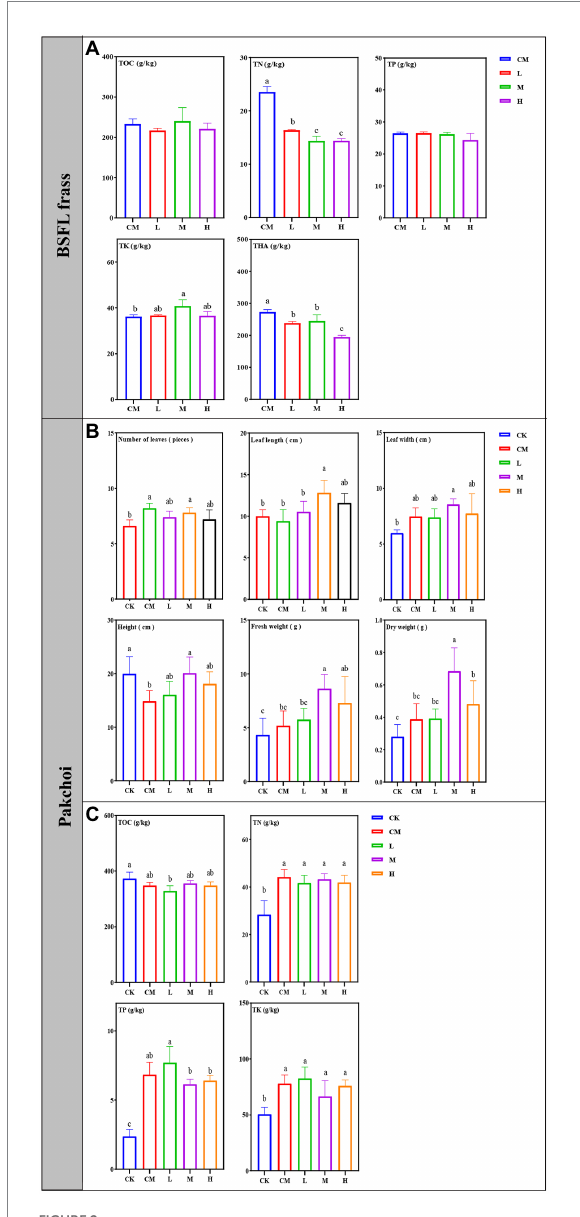
FIGURE 2 Physicochemical parameters of BSFL frass and pakchoi samples. (A) The contents of TOC, TN, TP, TK, and THA in BSFL frass among different treatments; (B) the leaf number, leaf length and width, height, fresh weight and dry weight of pakchoi among different treatments; (C) the contents of TOC, TN, TP, and TK in pakchoi among different treatments. Significant differences between the means were determined by Tukey’s test. Differences were considered significant when p < 0.05, and different lowercase letters indicate significant differences. “CK” means untreated soil, “CM” means untreated manure without BSFL, “L” means 50 BSFL cultured in 100 g of fresh manure, “M” means